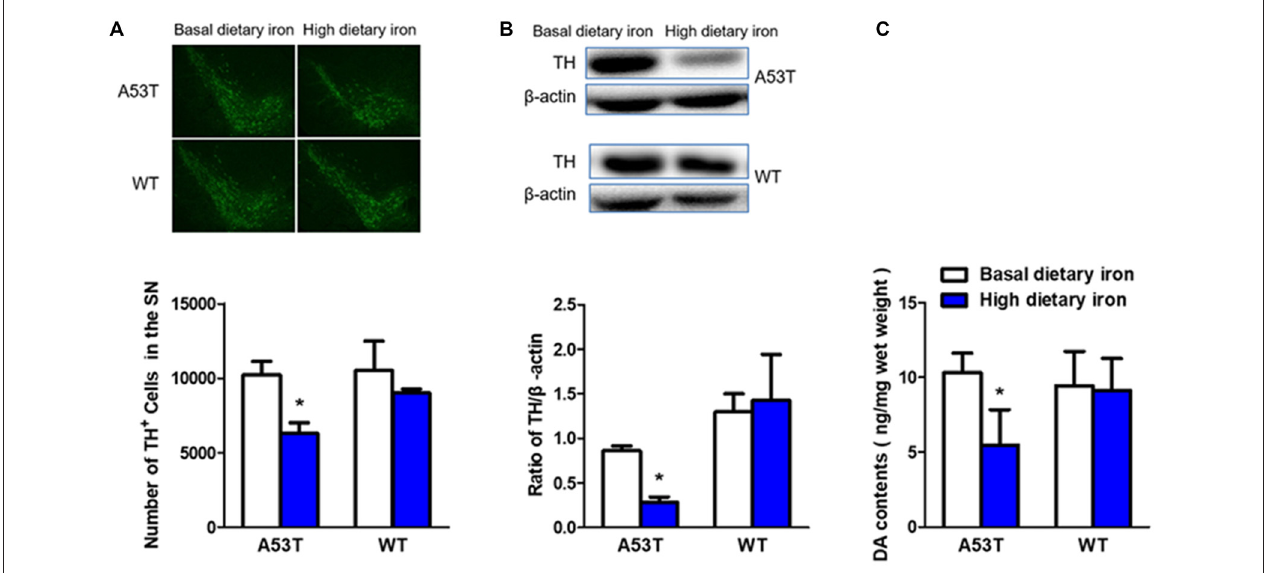
FIGURE 3 | Changes of dopaminergic neurons of A53T and WT mice with high dietary iron. In A53T mice, the number of dopaminergic neurons in substantia nigra (SN) (A) , level of tyrosine hydroxylase (TH) protein in SN (B) and DA contents in striatum (C) were lower in high dietary iron group compared to the basal dietary iron group. However, no changes were detected in the number of dopaminergic neurons in SN (A) , level of TH protein in SN (B) and DA contents in striatum (C) in WT mice. Each bar represented the mean ± SEM. ∗ P < 0.05, compared with the corresponding basal dietary iron group, n = 6.